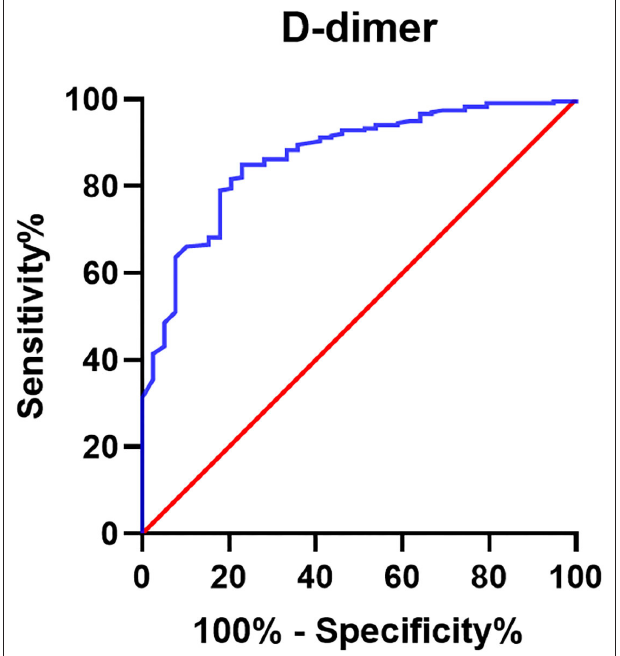
FIGURE 3 | Receiver operator characteristic curve of D-dimer for prediction of AAA in PAD group. Receiver operator characteristic curve of D-dimer was drawn for the prediction of AAA in patients with PAD ( n = 364). The AUC of D-dimer is 0.867.